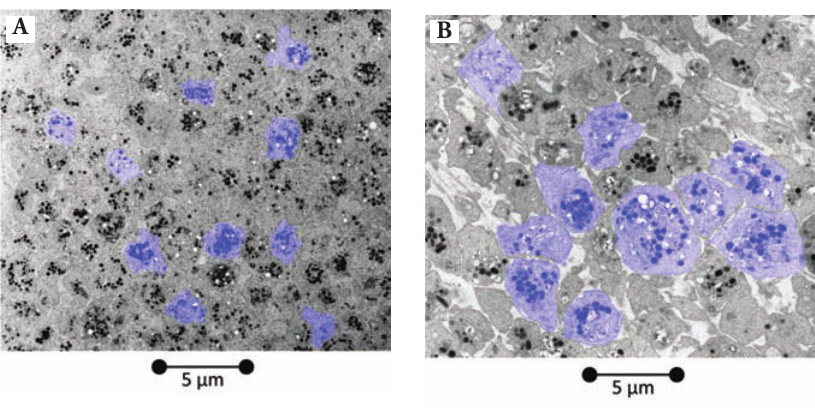
Figure 2. (A) Digital mask of electron microscopic PLT evaluation of a HD subject and (B) healthy reference subject. Masks are shown in blue. Magnification: